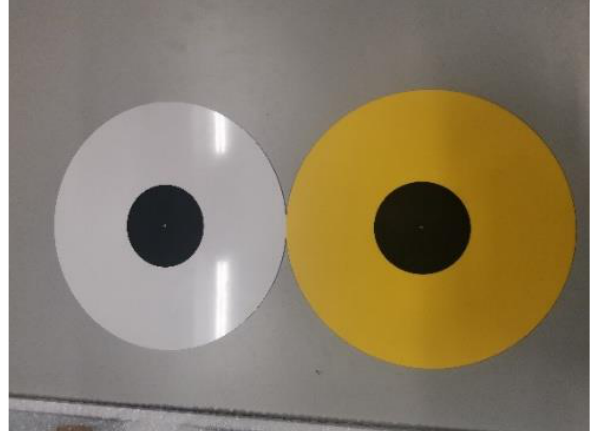
Figure 2. 300 mm diameter targets - CPs (l) and GCPs (r).